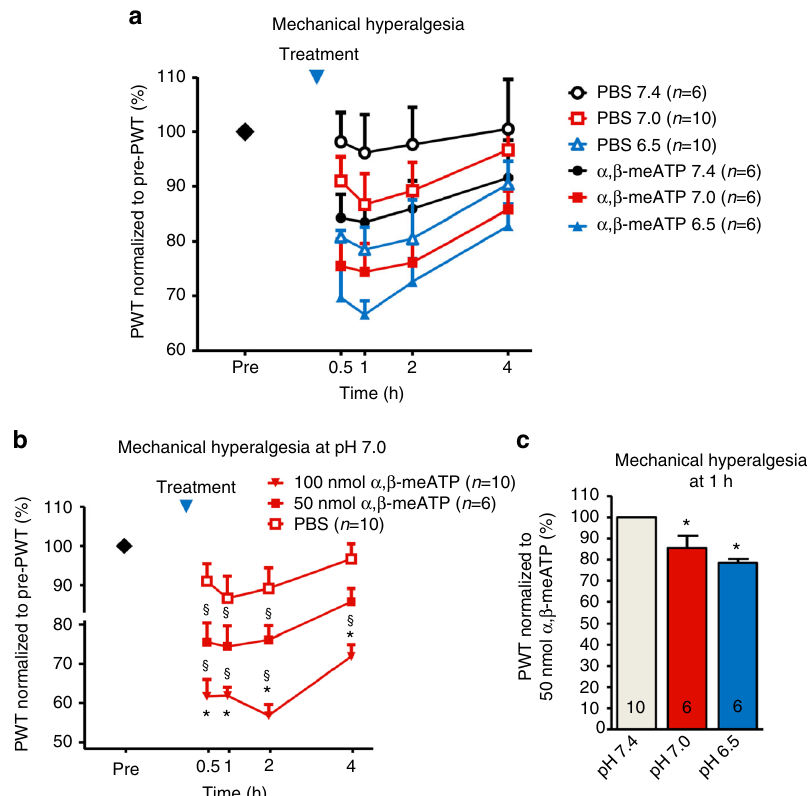
Fig. 10 The effect of normal and pH-adjusted PBS solution and α , β -meATP on mechanical hyperalgesia in rats. a Time – response curves of the effect of intraplantar (i.pl.) phosphate-buffered saline (PBS) or α , β -meATP (50 nmol) dissolved in PBS injected into the right hind paw at a volume of 100 µ l/paw on the baseline mechanical paw withdrawal threshold (PWT). Each point represents mean ± S.E.M. of the PWT in pressure as a percentage of baseline % applied to the hind paw before (pre) and after PBS/ α , β -meATP administration, obtained from the indicated number of rats. α , β -meATP decreased PWT both pH and time dependently post injection (repeated measures ANOVA time × treatment effect F 1,38 = 1.760, P < 0.00001). The changes from baseline PWT were at pH 7.4, 16.5% ( P = 0.0026, n = 6), at pH 7.0, 25.6% ( P = 0.001, n = 6), at pH 6.5, 33.3% ( P < 0.001, n = 6, one-way ANOVA followed by the Dunnett test) at 1 h. For the sake of clarity, statistical signi fi cance is not indicated in the fi gure. b Dose-dependent effect of α , β -meATP on mechanical hyperalgesia at pH 7.0. § P < 0.05; statistically signi fi cant difference vs. baseline; * P < 0.05; statistically signi fi cant difference vs. PBS. Results were analyzed by repeated measures ANOVA, followed by Neuman – Keuls test, n = 6 – 10 animals per group. c The effect of acidi fi cation on α , β -meATP-induced hyperalgesia. PWT values were normalized to the response obtained by 50 mM α , β -meATP at pH 7.4. * P < 0.05; statistically signi fi cant difference from the 100%. Results were analyzed by one-way ANOVA followed by Tukey test, n = 6 animals per